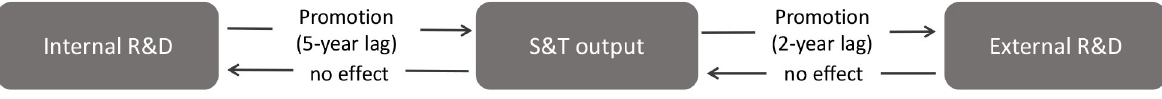
Fig 6. The relationship between two R&D Strategies and S&T